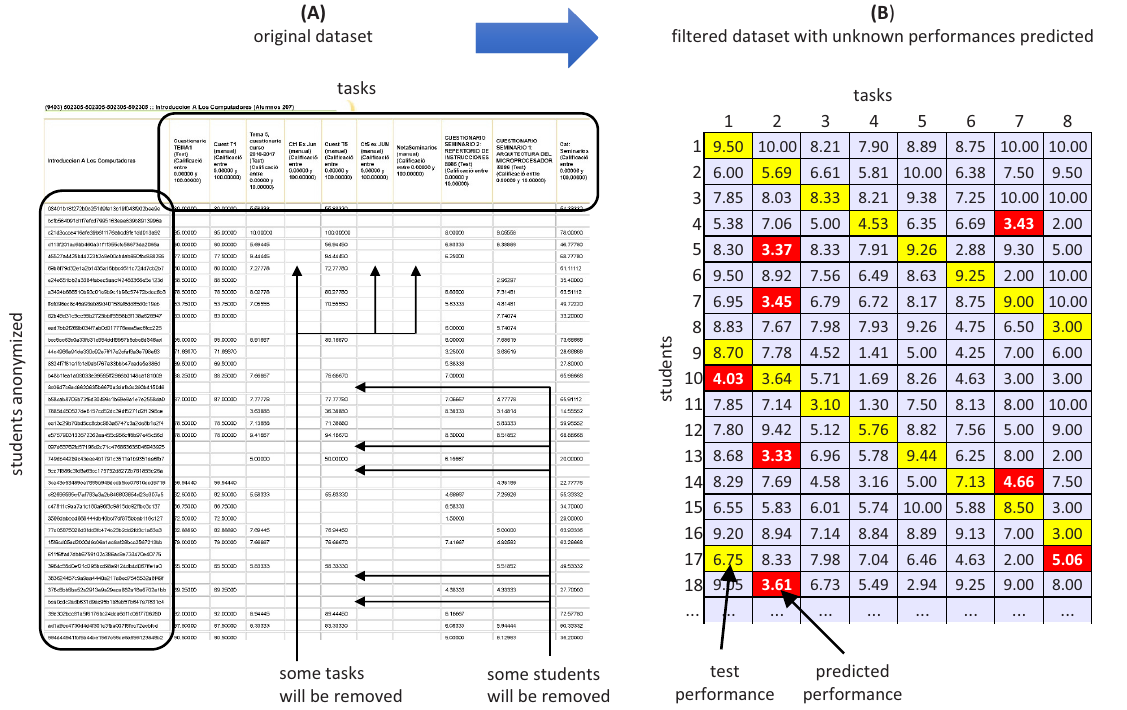
Figure 3. Real case of the dataset extracted from the virtual classroom ( A ) and filtered and predicted ( B